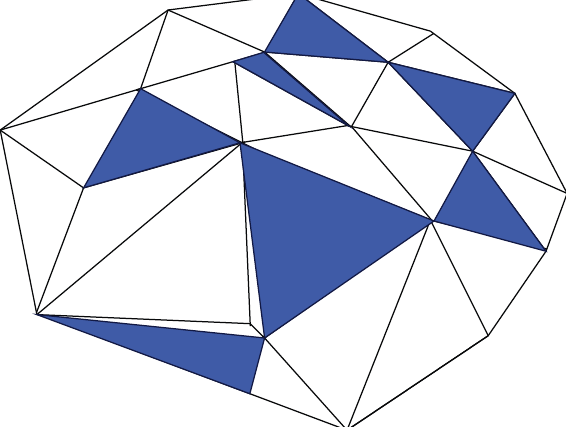
Figure 2: Grid of scattered data points.